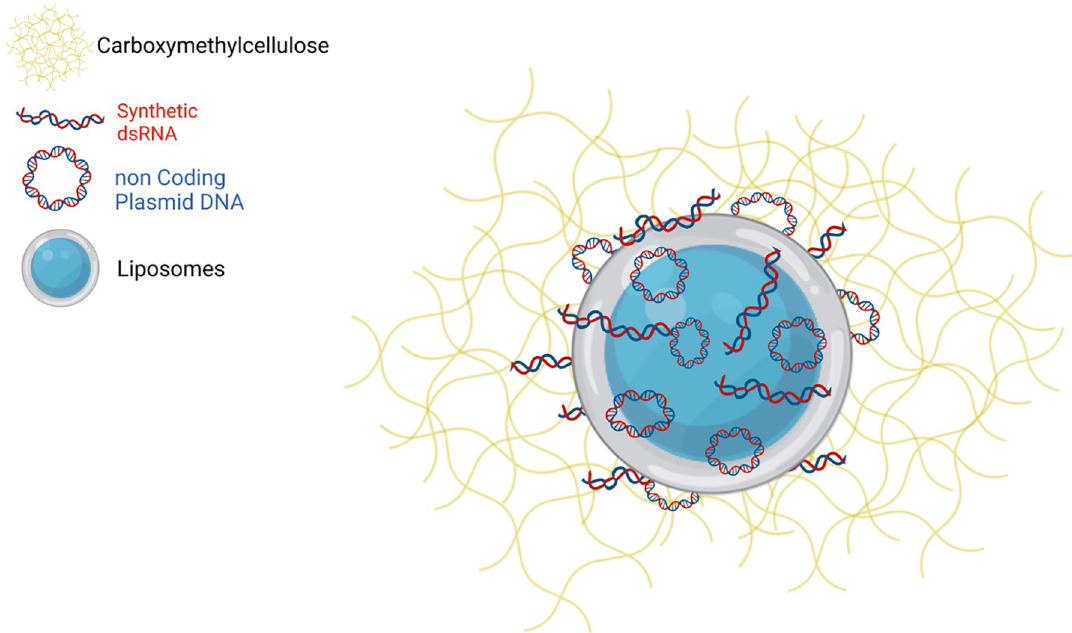
Fig 1. Diagram of LTAC immune nanoparticles. The LTAC nanoparticles consist of a cationic liposome core, to the surface of which immune stimulatory nucleic acids polyinosinic, polycytidylic acid (synthetic dsRNA), which is a TLR3 agonist; and CpG ODN, (non coding plasmid DNA) which is a TLR9 agonist are complexed by charge interactions. The addition of CMC (Carboxymethylcellulose) after the liposome-nucleic acid complexes are formed provides a loose outer coating to increase adherence to the surface of mucosal tissues, including epithelial cells, and improve overall uptake of the LTAC